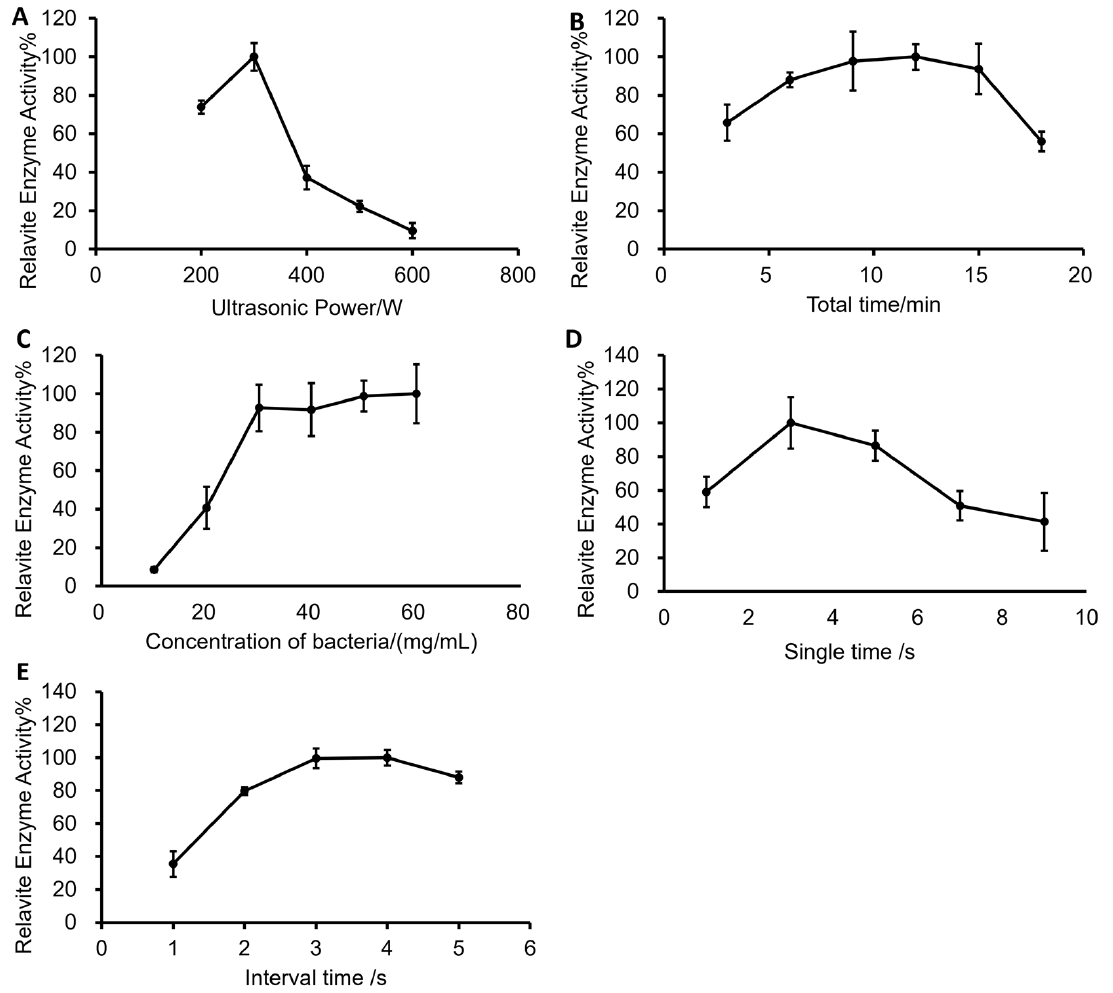
Figure 3. Optimum conditions and factors affecting enzymatic activity during ultrasonication. ( A ) Ultrasonic power. ( B ) Total time. ( C ) Concentration of bacteria. ( D ) Single time. ( E ) Interval time.